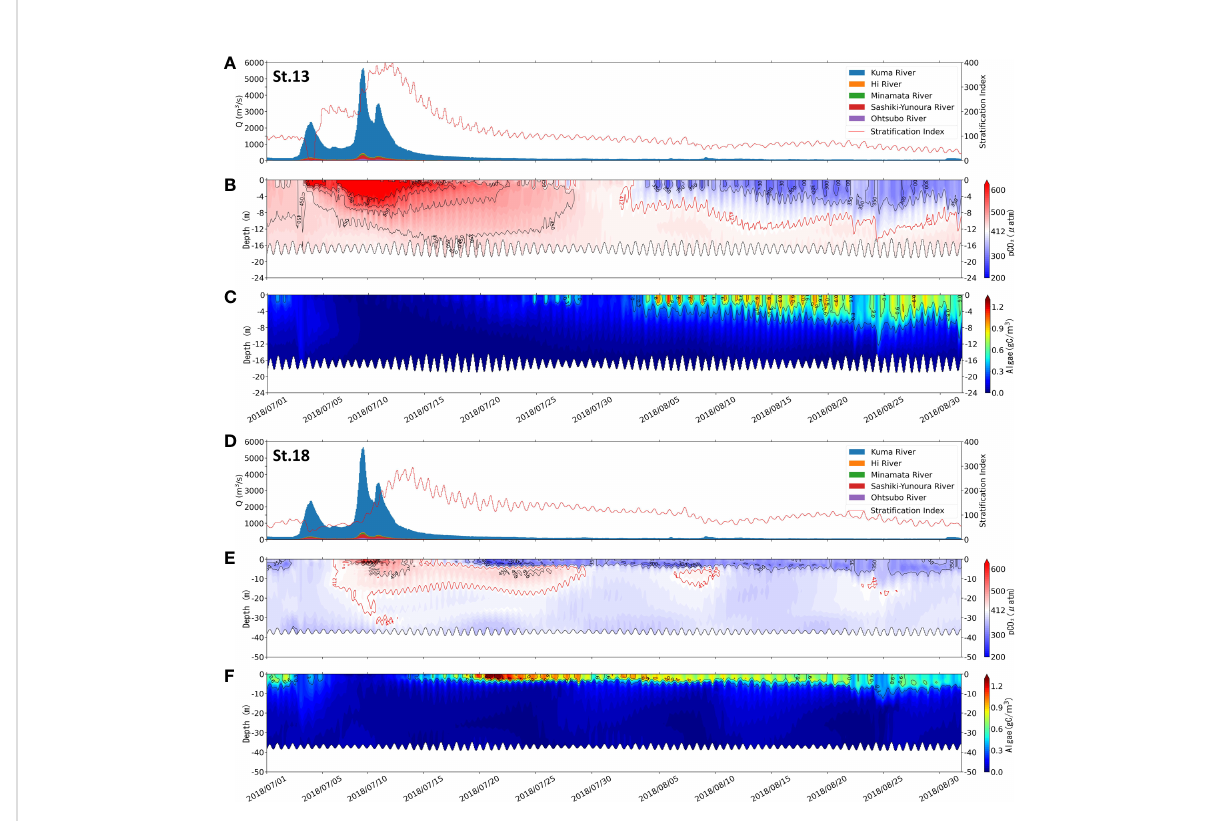
FIGURE 5 Comparison of the fl ow rate of the rivers fl owing into the Yatsushiro Sea and strati fi cation index (A, D) , pCO 2 distribution (B, E) , and algae biomass distribution (C, F) at St.13 (A – C) and St.18 (D – F) from 1 July 2018 to 1 September